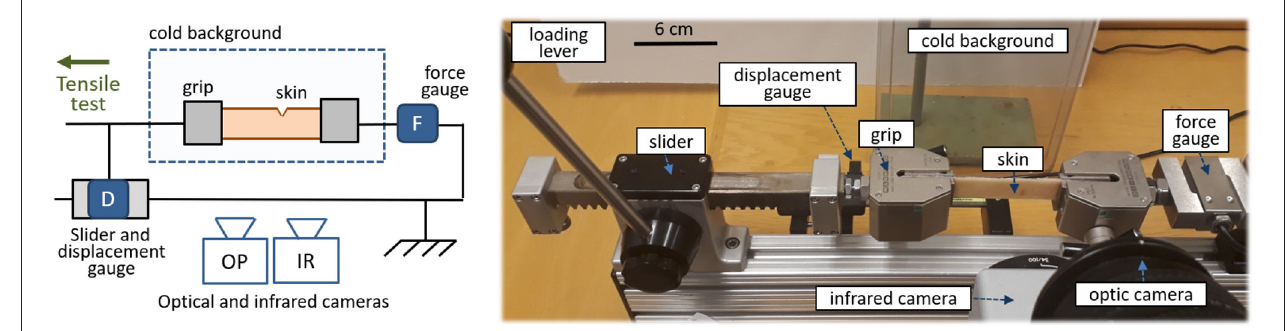
FIGURE 1 | Schematic (left) and picture (right) of the experimental set-up. Porcine skin is teared in front of an optical and an infrared camera, while both the applied force and displacement are measured. In the real set-up (e.g., by contrast to what is suggested by the schematic) the optical camera is placed above the infrared one.